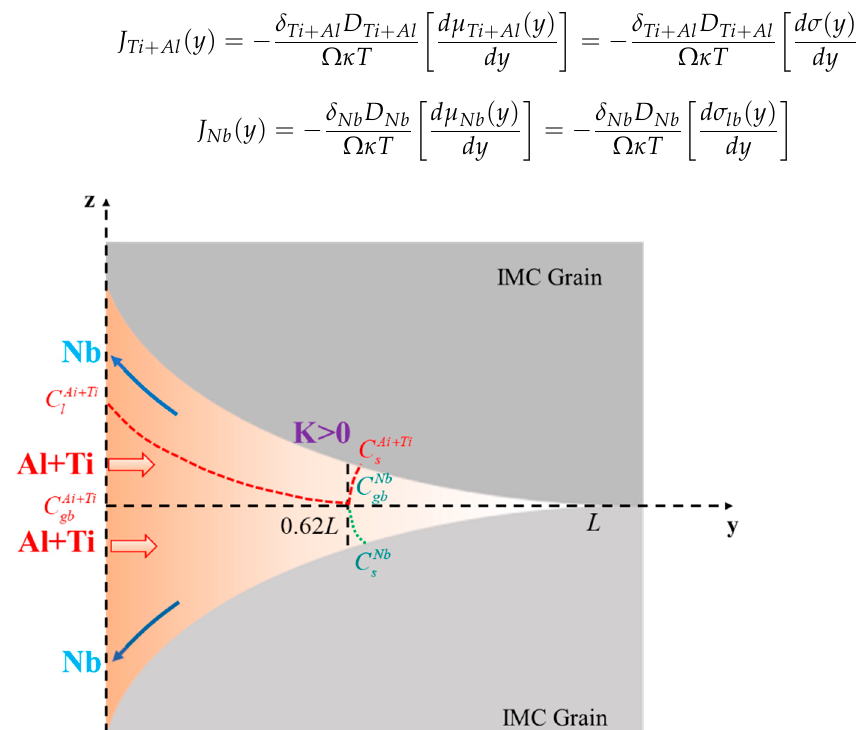
Figure 5. Illustration of diffusion of Al, Ti and Nb atoms along the V-type GB in the solid IMC phase. The diffusion concentration in the GB has a subscript gb, and those of in surface with a subscript s and in TiAl melt with a subscript l , respectively.